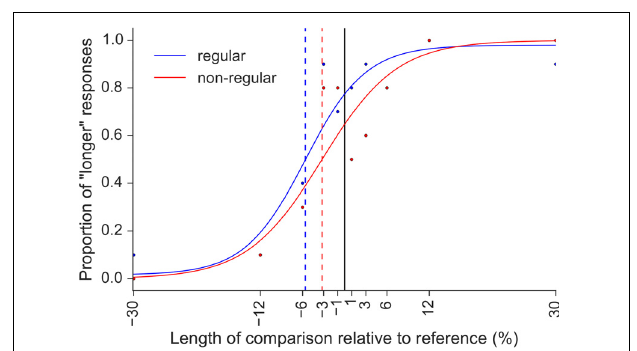
FIGURE 1 | Example of the psychometric functions fitted in Experiment 1 for participant S9 and 660 ms reference, with regular (blue) and non-regular (red) auditory context. The PSE values (indicated by vertical dashed lines) were expressed as percentage of increase (1, 3, 6, 12, and 30%) or decrease (–1, –3, –6, –12, and –30%) in the length of the comparison relative to the reference interval. In this example, the PSE values of –5.6% measured with regular auditory context indicates that the comparison had to be 5.6% of 660 ms shorter than the reference, to be perceived as of equal